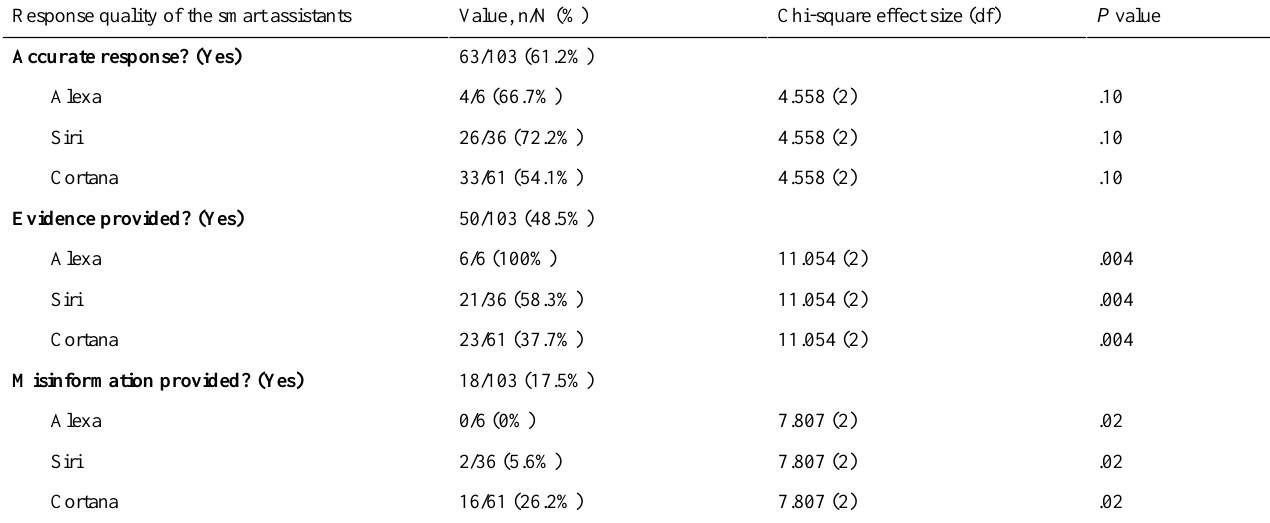
Table 3. Response differences among smart assistants in terms of accuracy, evidence provided, and misinformation.